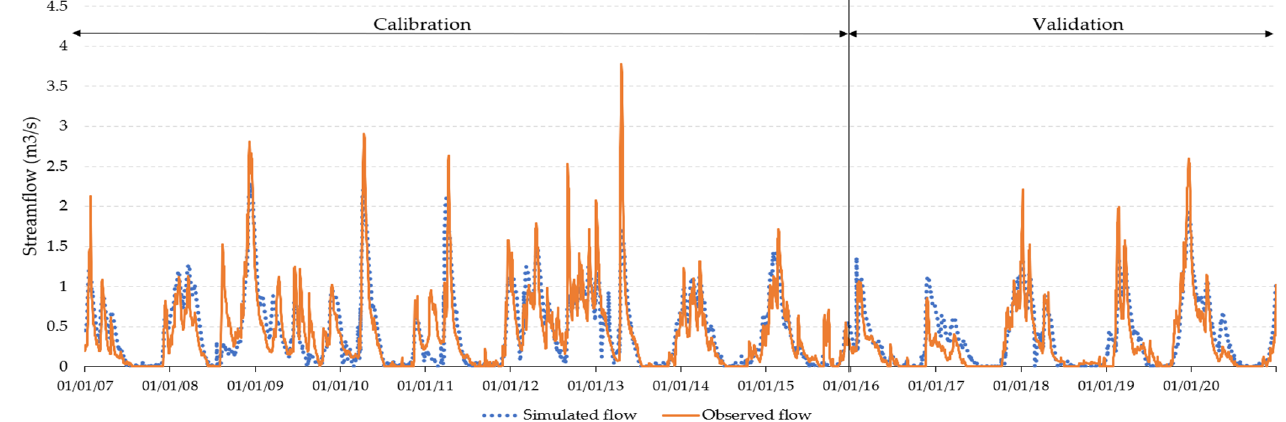
Figure 3. Calibration and validation of the SWAT+ model streamflow (daily values).